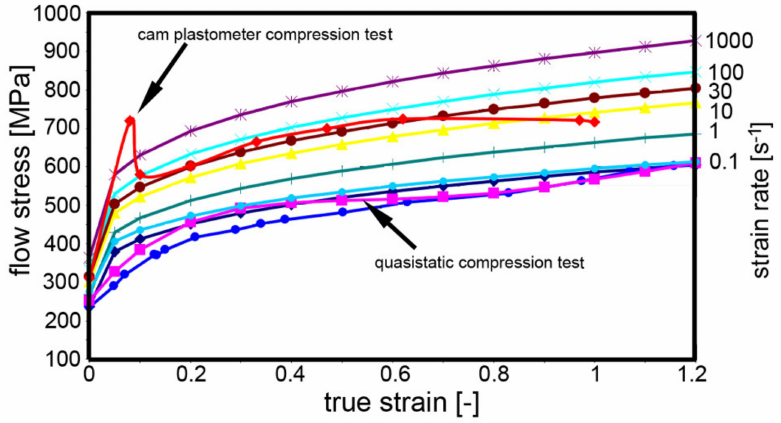
Figure 11. Flow stress curves for TRISTAL steel for temperature of 23 ◦